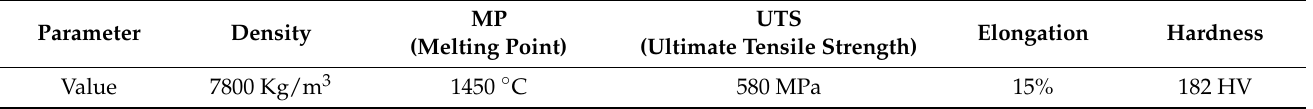
Table 2. Mechanical properties of the A441 AISI steel.